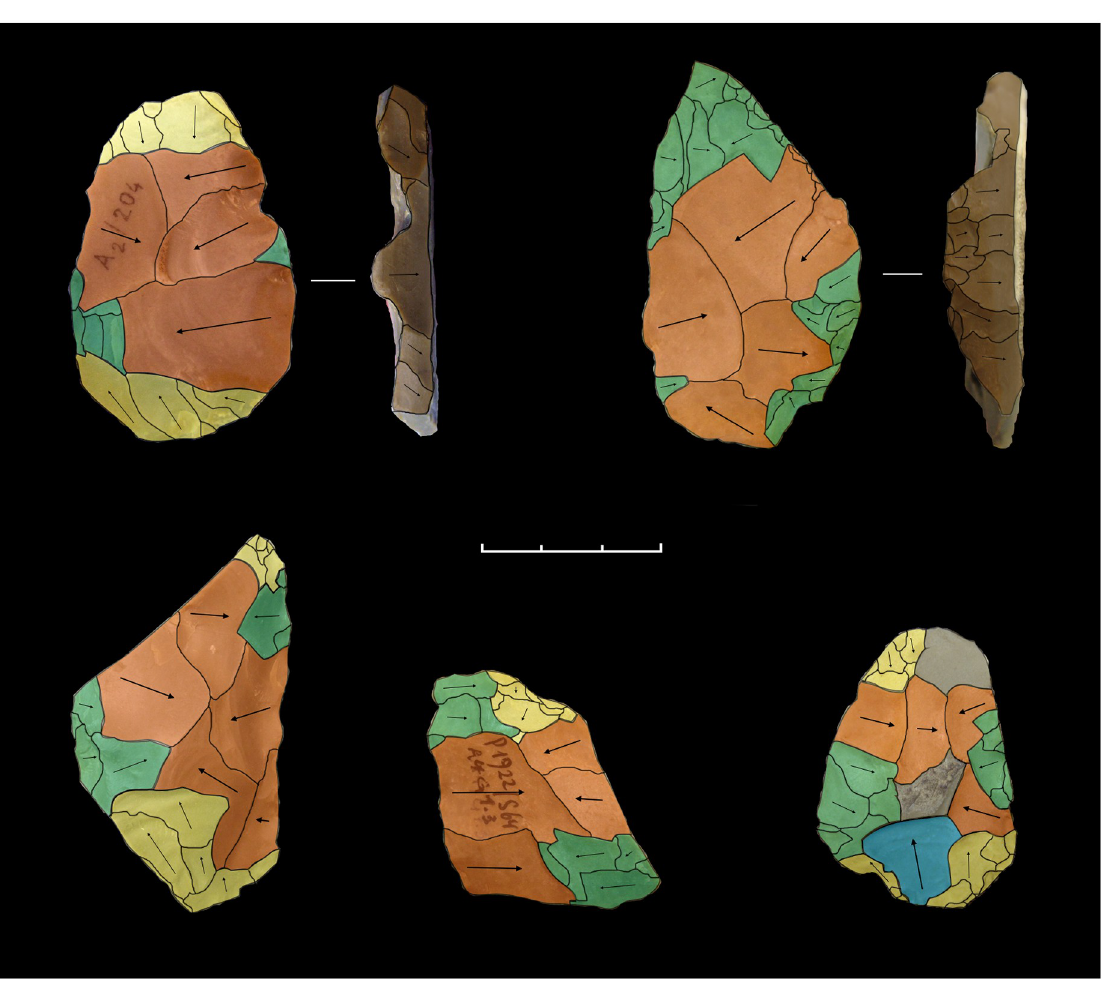
Fig 20. Diacritic schemes of Keilmesser core-blanks showing the patterns of reduction and exploitation of the lower surface and, occasionally, the preparation of the back, used as striking platform. The red and blue detachments may represent those aimed at creating usable blanks, while the yellow and green ones at managing the lateral convexities and regularizing the surface. From the top left: P1963/S64; P5791/S65; P5596/S65; P1922/S64; S3887/69.